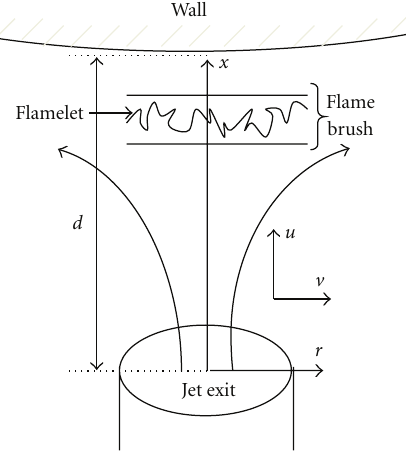
Figure 1: Premixed turbulent flame stabilized in an impinging